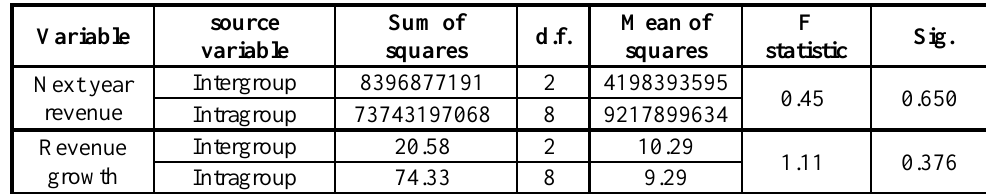
Table 5. One-way ANOVA to compare groups (providing non-financial information alone and high knowledge)